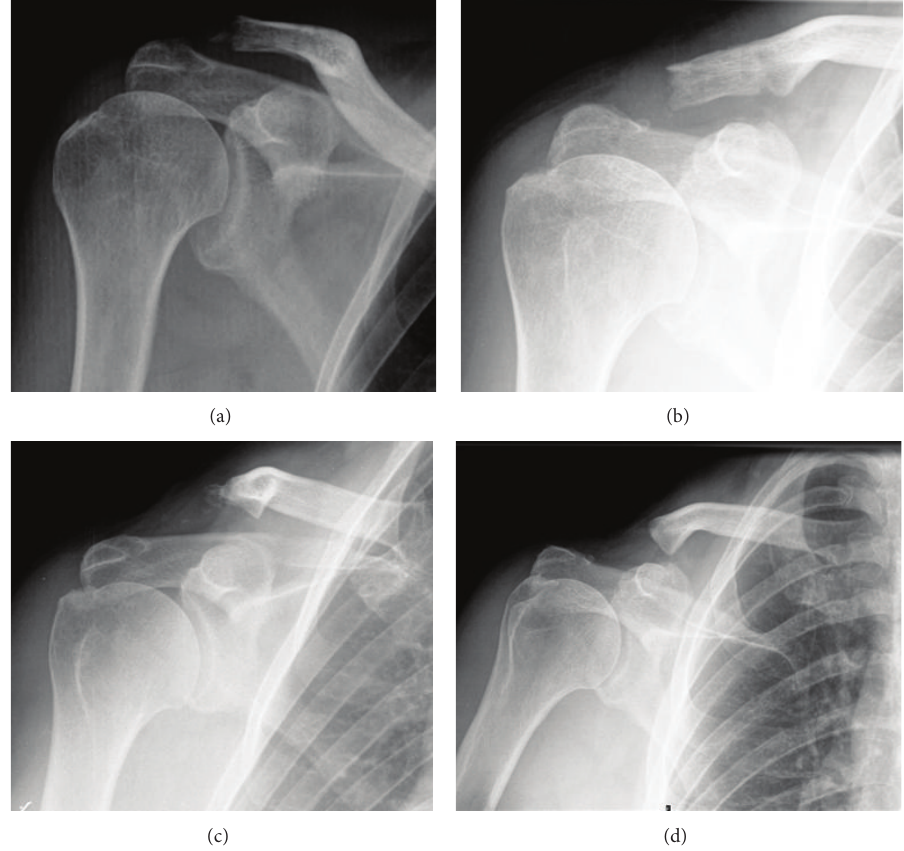
Figure 1: Serial of plain radiographs during the follow-up demonstrating the progression of the distal clavicle osteolysis. (a) 2 weeks after surgery. (b) 2 months after surgery. (c) 1 year after surgery. (d) 2 years after